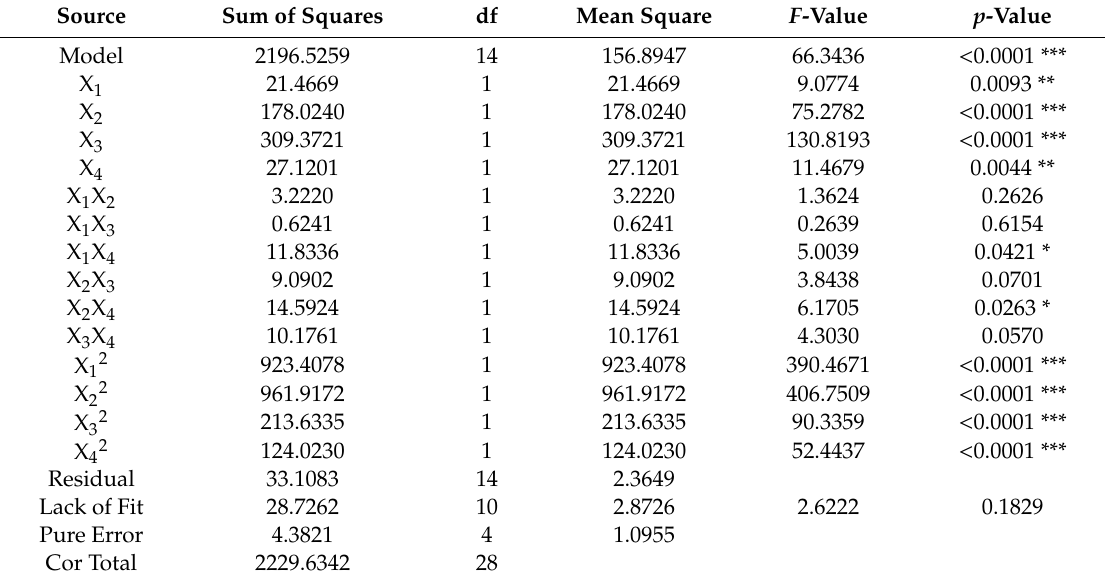
Table 2. ANOVA for Box–Behnken